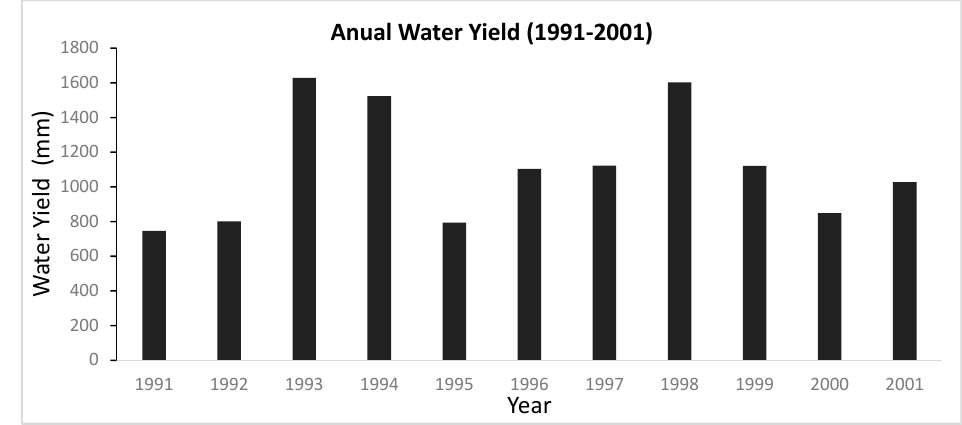
Figure 8. Annual water yield for the entire